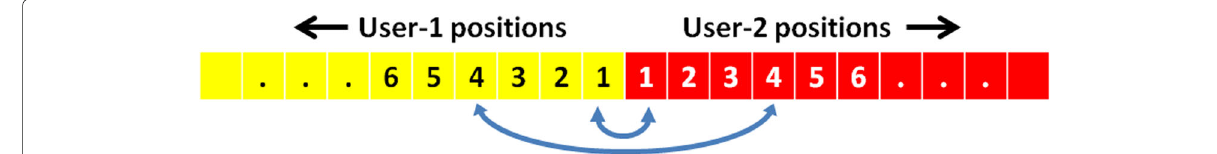
Fig. 2 Illustration of the separation of the simultaneous users in the single-cell macro base station scenario